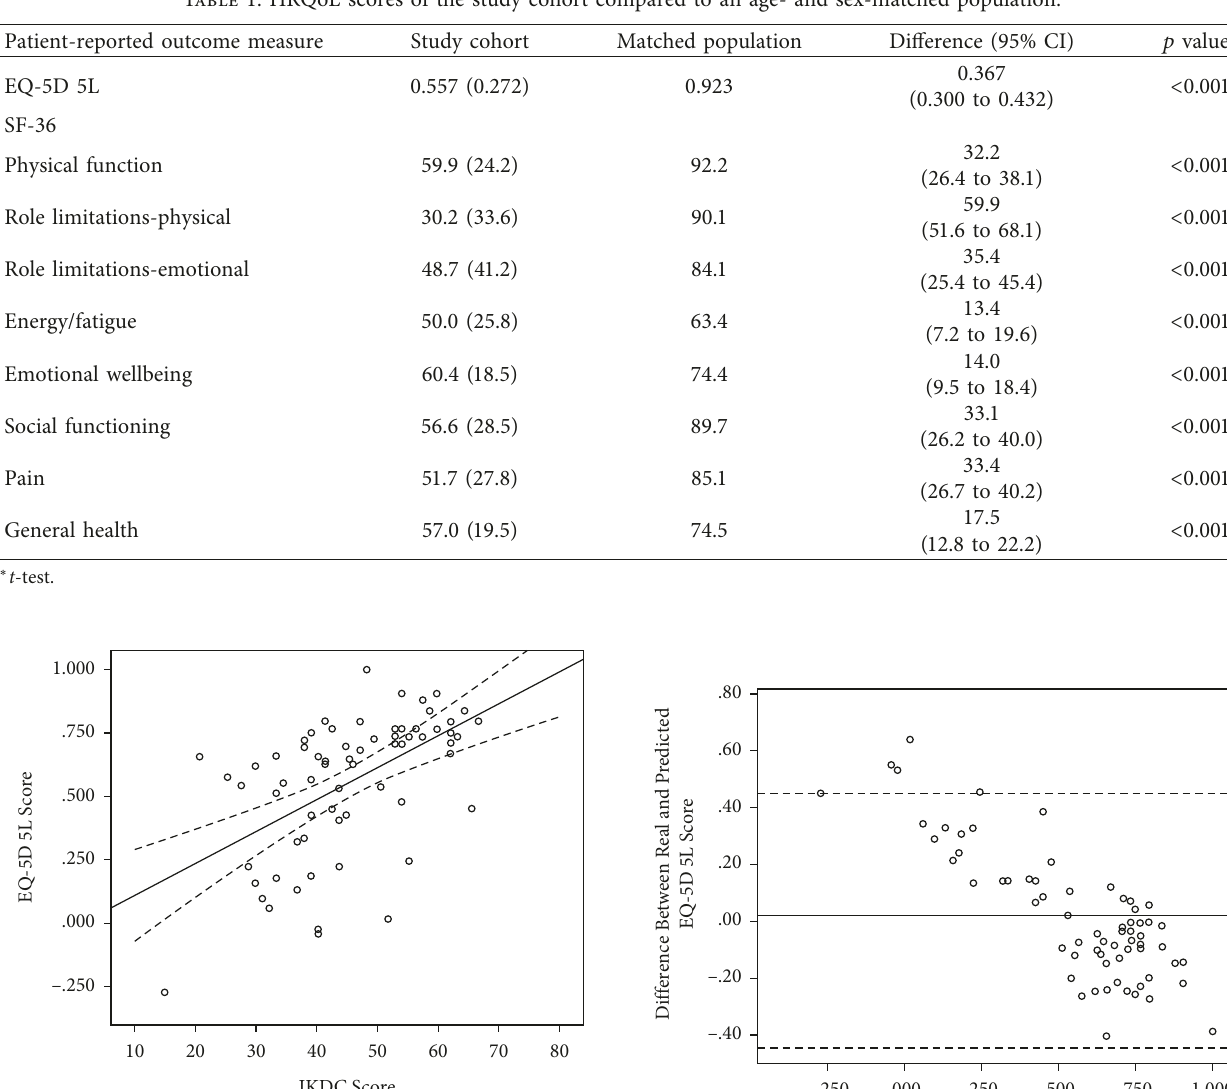
Table 1: HRQoL scores of the study cohort compared to an age- and sex-matched population.